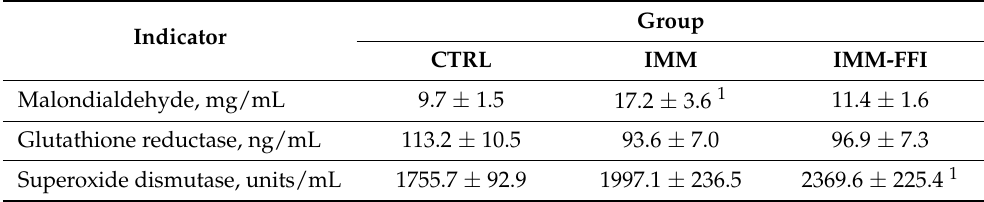
Table 5. Indicators of the antioxidant status of rats’ blood.